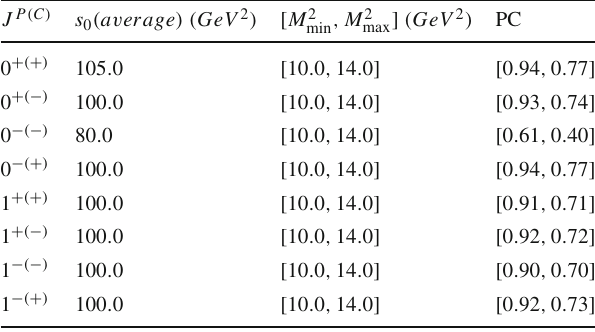
Table 4 Values of PC for different quantum numbers of the ground state bottom-strange hybrid mesons